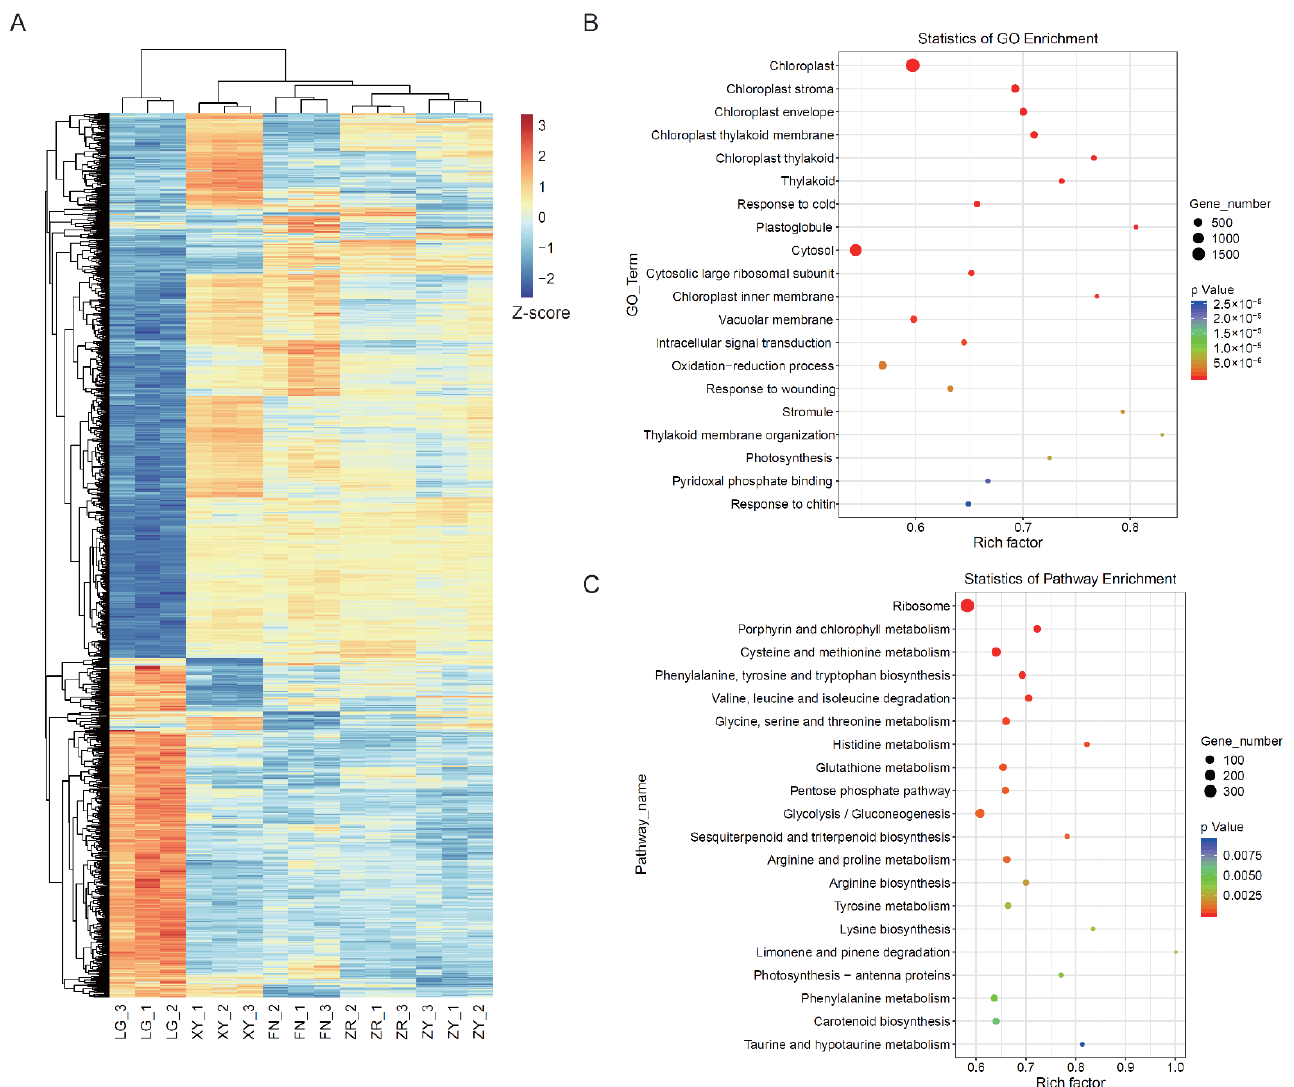
Figure 3. Global characterization of gene expression patterns of ripen sea buckthorn fruit of different colors: ( A ) cluster dendrogram showing the relationship of global gene expression patterns of five sea buckthorn fruits; ( B ) the GO enrichment analysis of the differently expressed genes in the fruits of five sea buckthorn varieties; ( C ) the KEGG enrichment analysis of the differently expressed genes in the fruits of five sea buckthorn varieties.